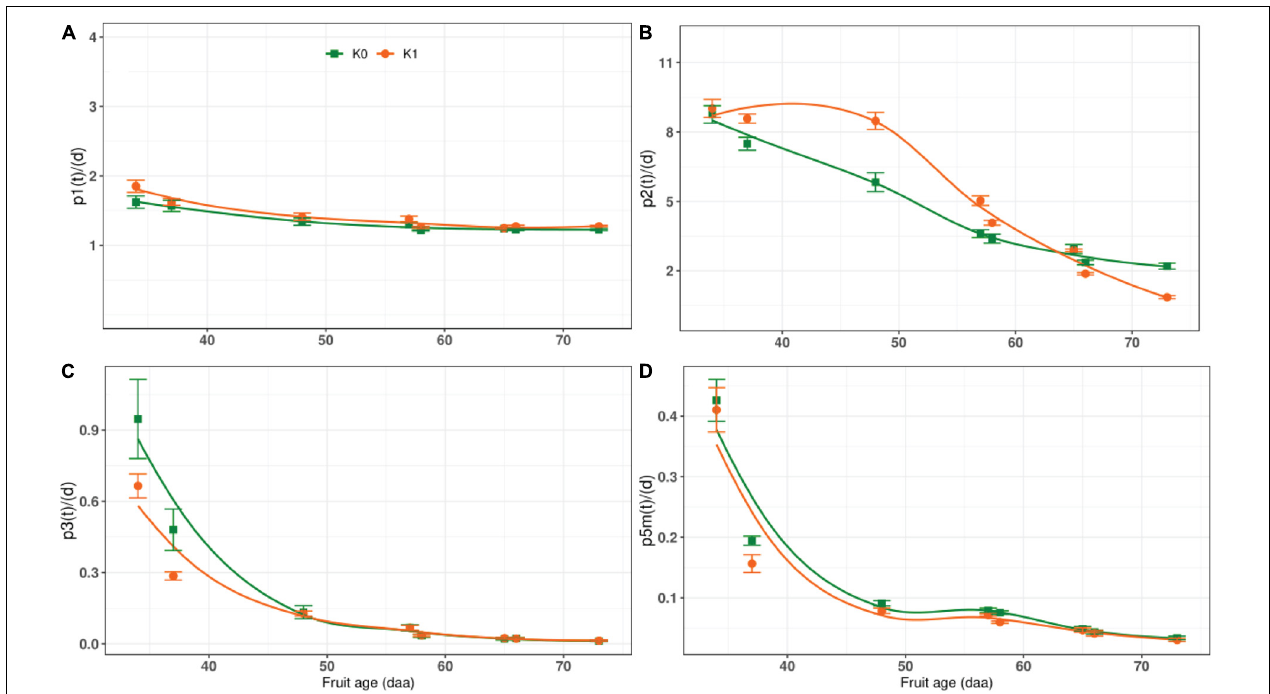
FIGURE 6 | The rate of carbon conversion during the whole growth stage. K 0 indicates no potassium and K 1 indicates potassium application. (A) The change of carbon conversion rate of sucrose to hexose with fruit age under different potassium condition. (B) The change of carbon conversion rate of hexose to sucrose with fruit age under different potassium condition. (C) The change of carbon conversion rate of hexose to other compounds with fruit age under different potassium condition. (D) The change of carbon conversion rate of glucose to starch with fruit age under different potassium